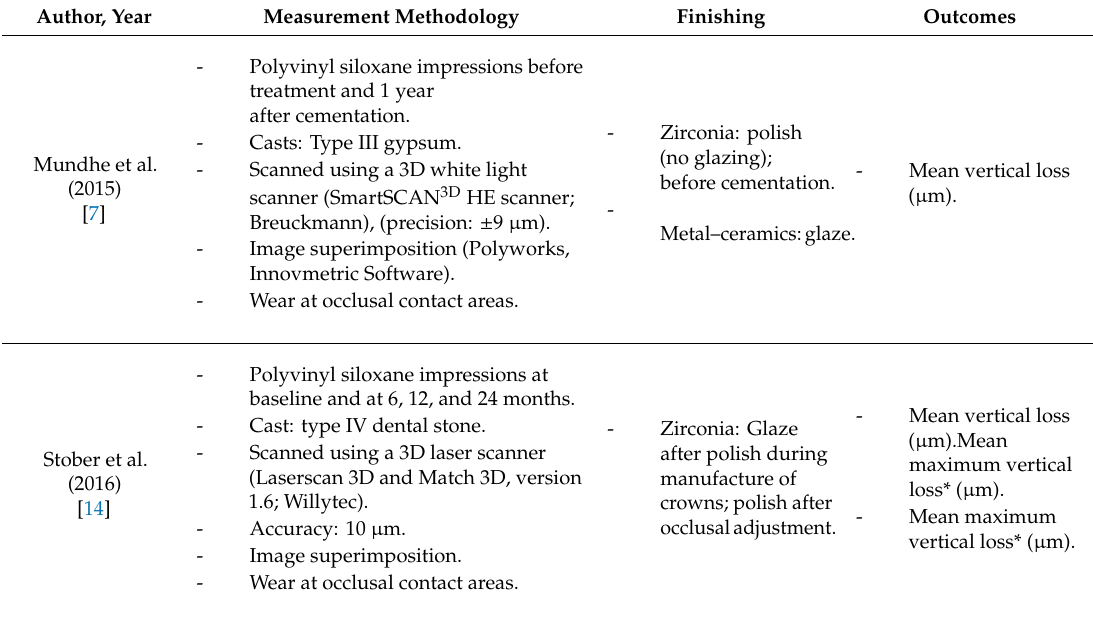
Table 4. Measurement methods, surface treatment (finishing) and unit of measurement of results of the studies